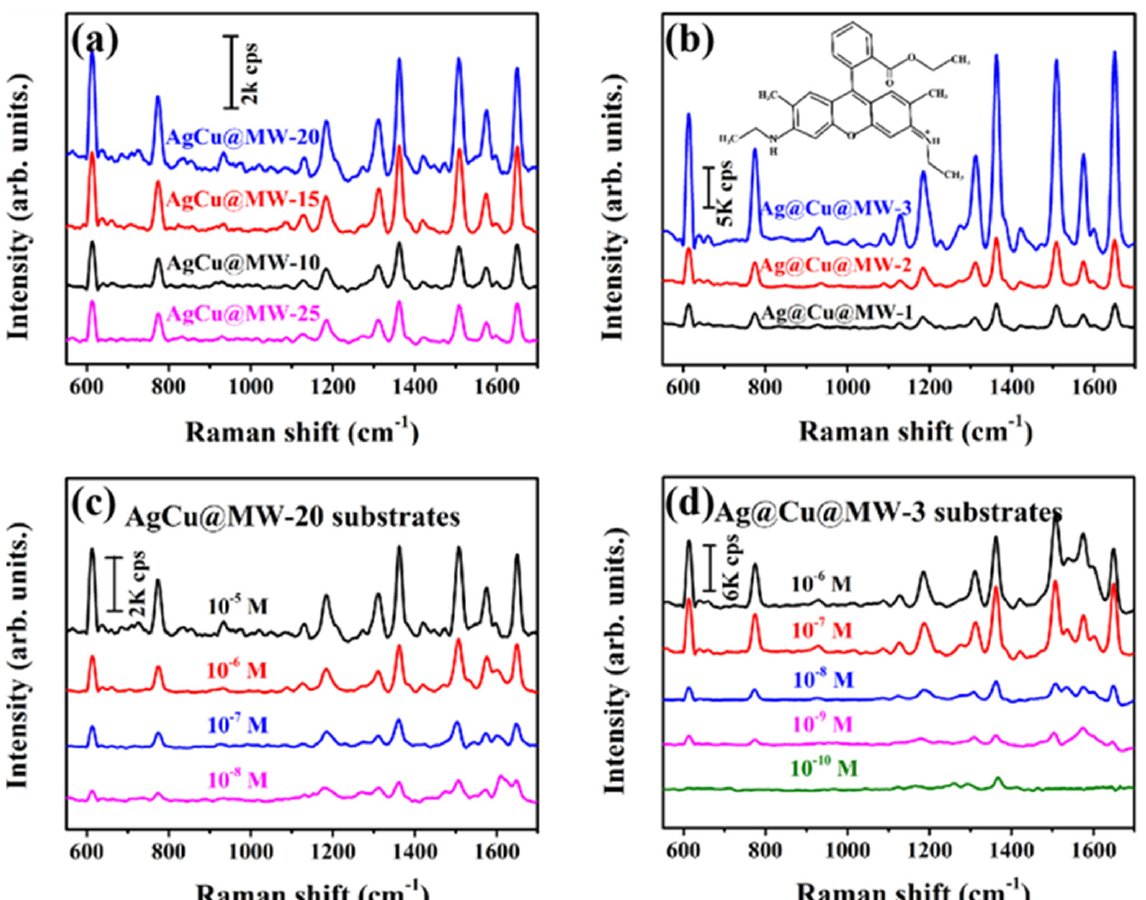
Figure 2. ( a ) SERS spectra of 10 − 5 M R6G solution on AgCu@MW substrates with different co ‐ sputtering times. ( b ) SERS spectra of 10 − 5 M R6G solution on Ag@Cu@MW substrates with sequentially alternating sputtering. ( c , d ) SERS spectra collected from different concentrations of R6G solution absorbed on the AgCu@MW ‐ 20 and Ag@Cu@MW ‐ 3 substrates.